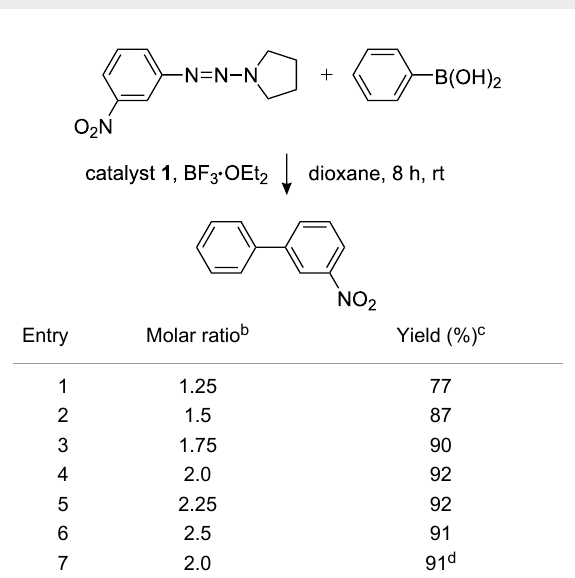
Table 3: Effect of the molar ratio of substrates on the cross-coupling reactions a .